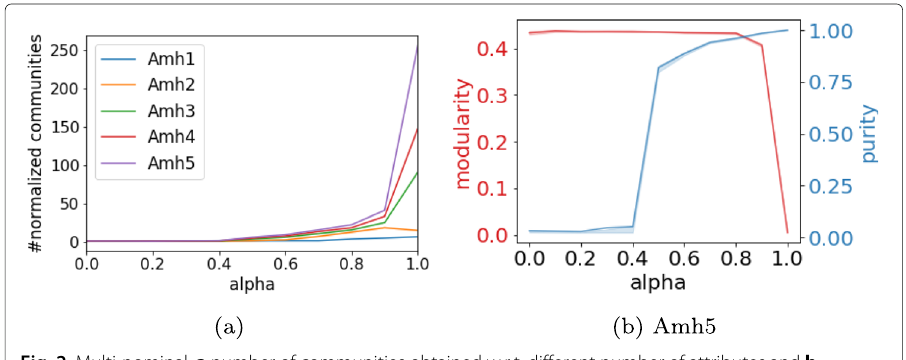
Fig. 2 Multi-nominal: a number of communities obtained w.r.t. different number of attributes and b modularity-purity trend in Amherst labeled with 5 attributes